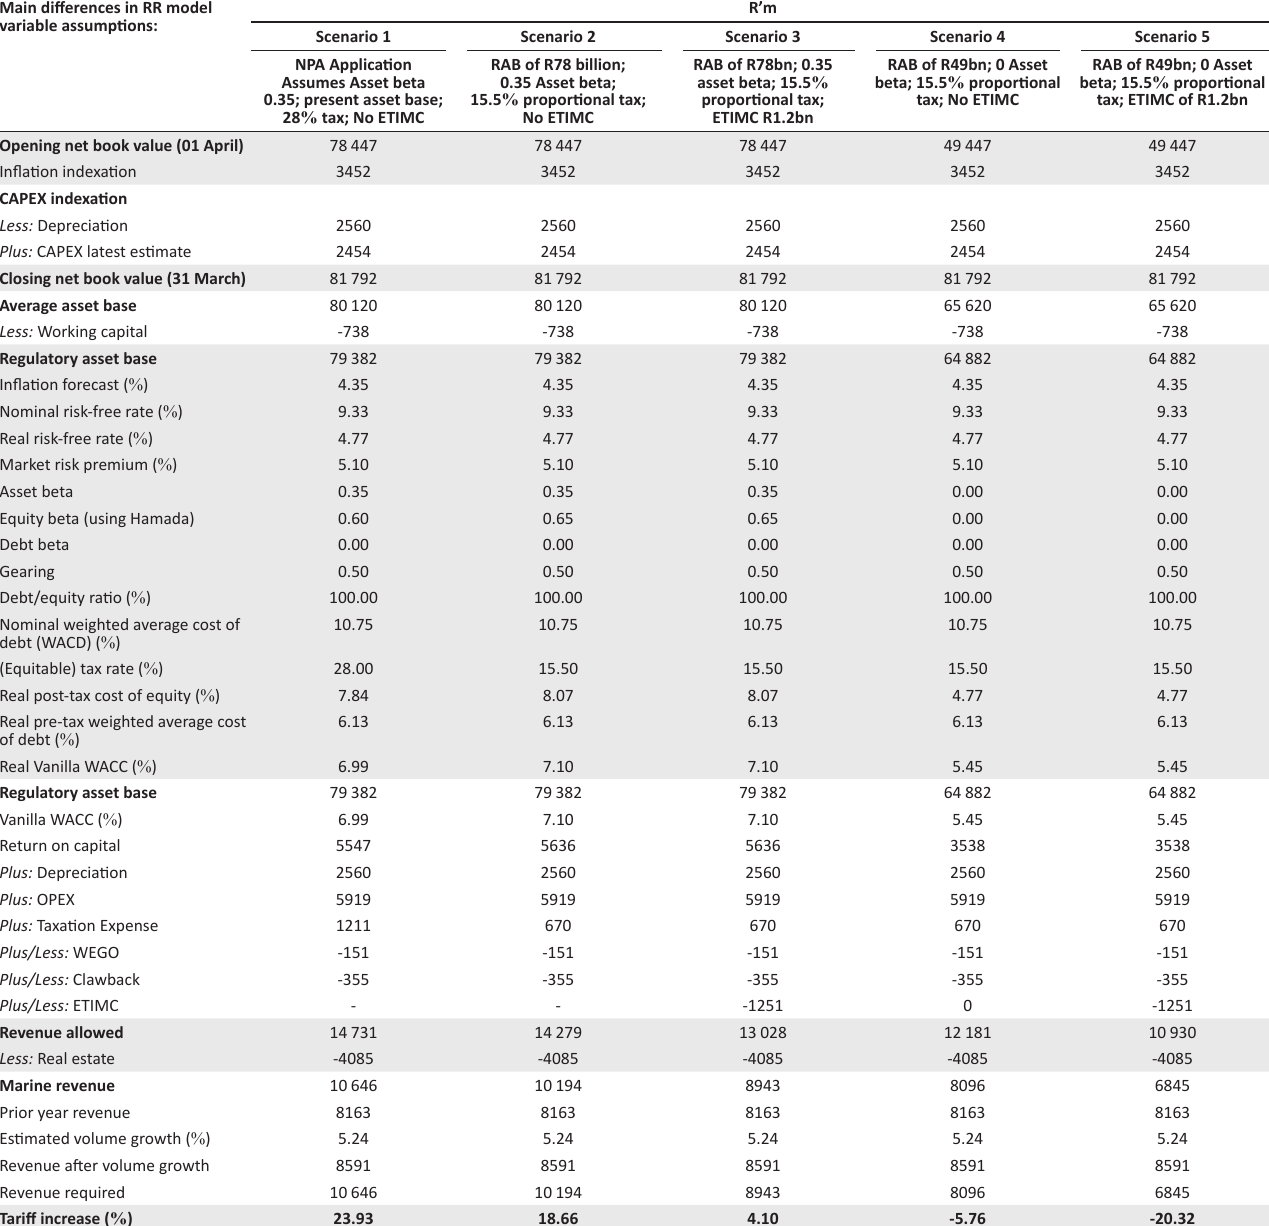
TABLE 1: Recalculation of the National Ports Authority tariff application for 2022 and 2023: five scenarios. Main differences in RR model variable